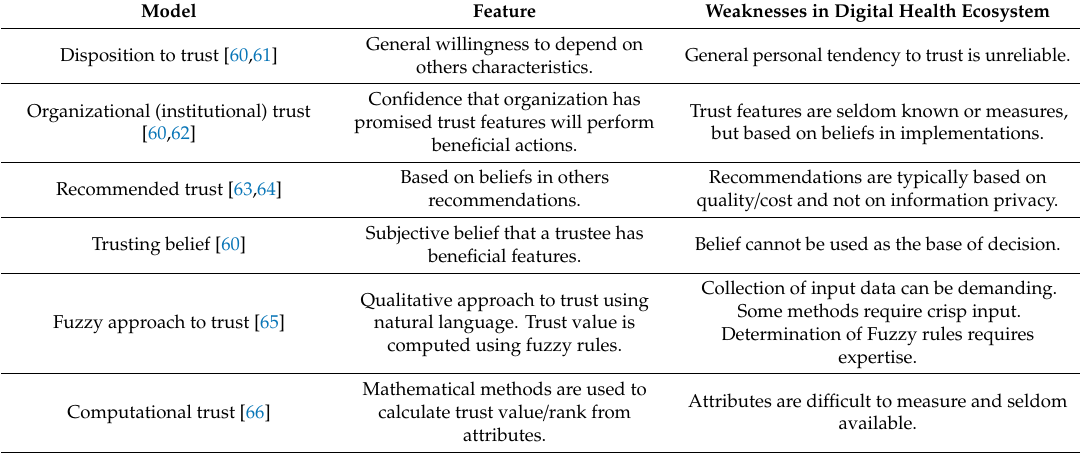
Table 3. Widely used trust models and